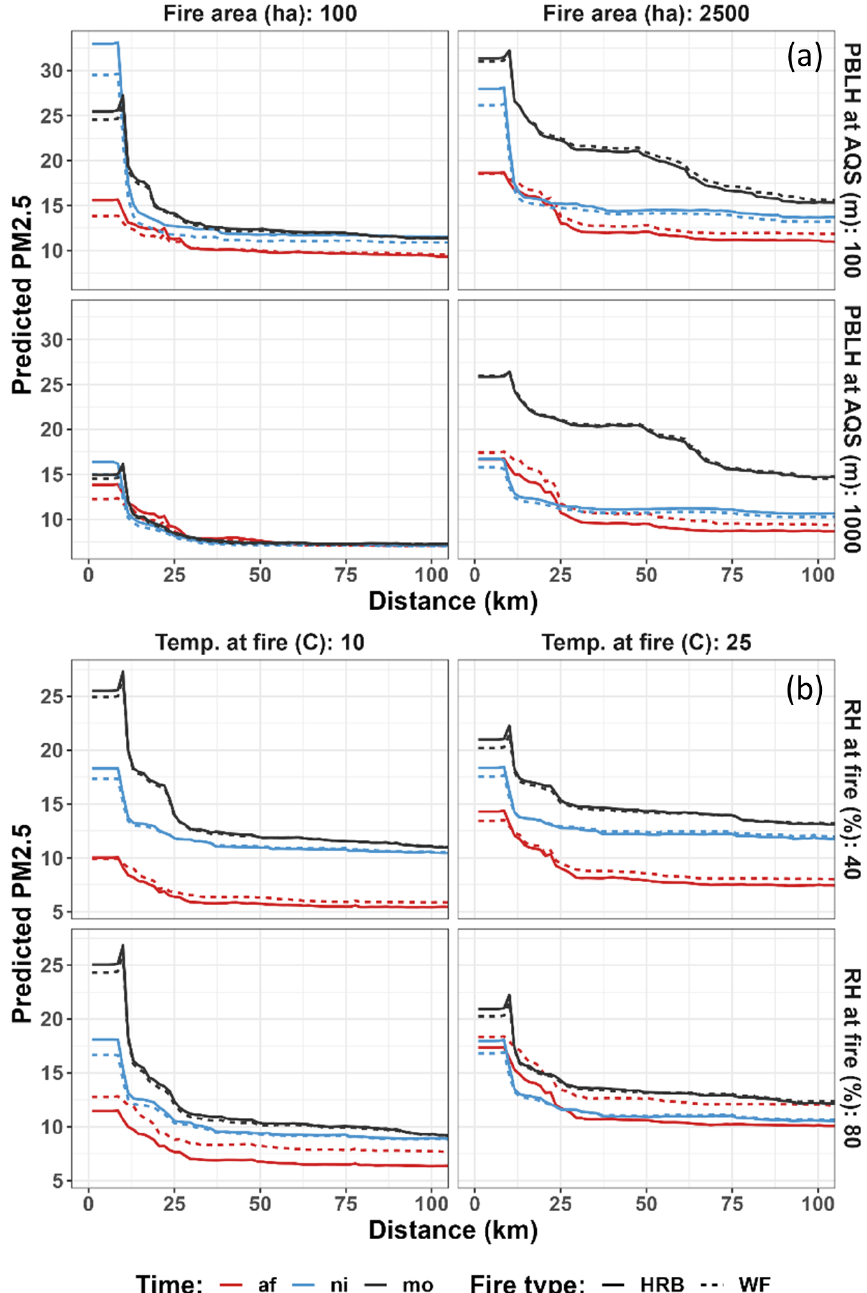
Figure 8. Predicted effects of selected variables on mean PM 2 . 5 . Colours are time periods; line types are fire types; grid squares are com- binations of the daily active fire area and planetary boundary layer height at the air quality monitoring station (a) and relative humidity and temperature at the fire (b)